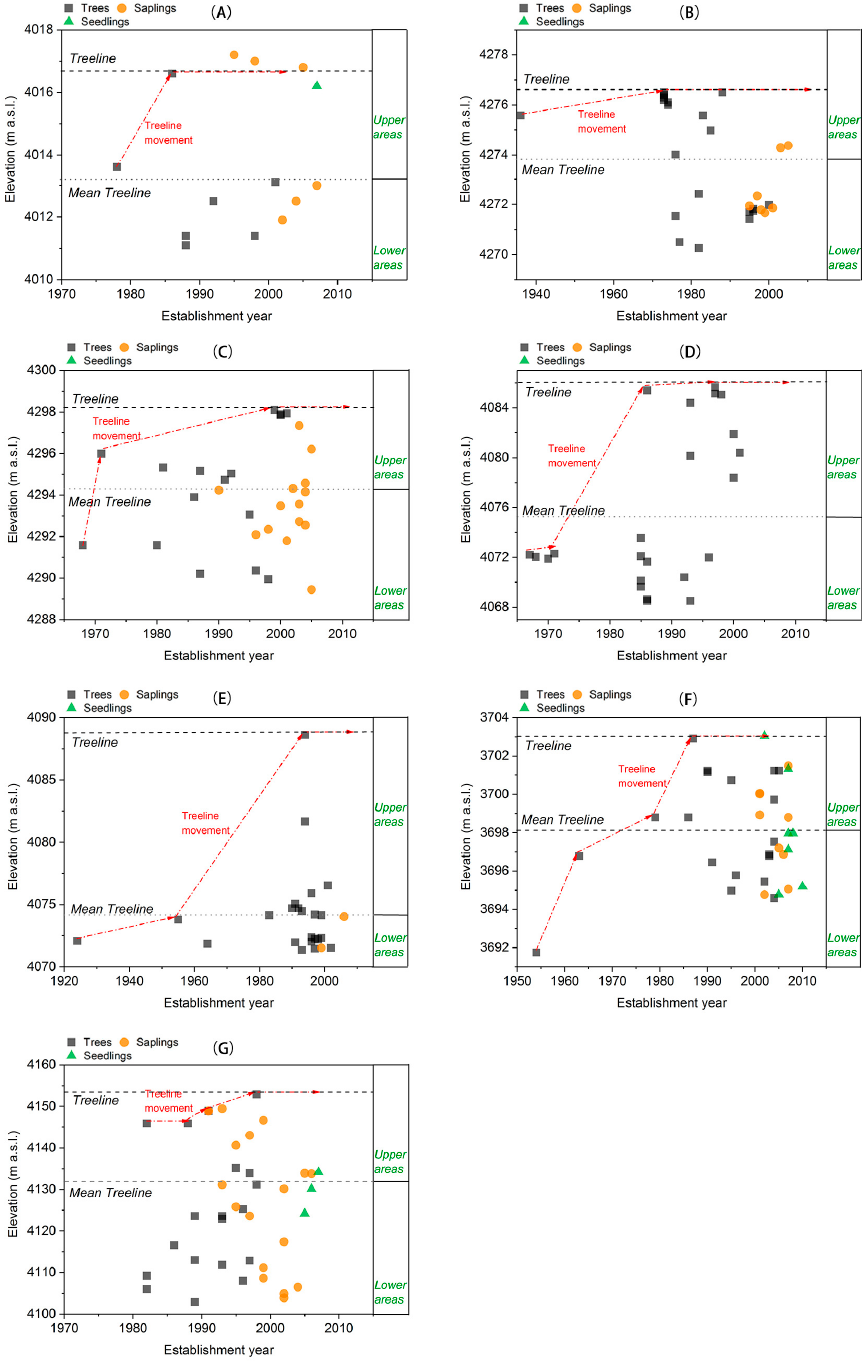
Figure 4. Larix treeline dynamics within each sampling site in the alpine treeline ecotone in the eastern Tibetan Plateau during the period of 1971–2014 (( A ): site N1; ( B ): site N2; ( C ): site N3; ( D ): site N4; ( E ): site N5; ( F ): site S1; and ( G ): site S2). Definition of treeline, mean treeline, upper areas, and lower areas are given in the text (see Materials and Methods). Gray-filled squares, orange-filled circles, and green-filled triangles represent trees, saplings, and seedlings, respectively. Treeline movements are shown by the red dash-dot line with arrows. Note the different scale for x- and y-axes.